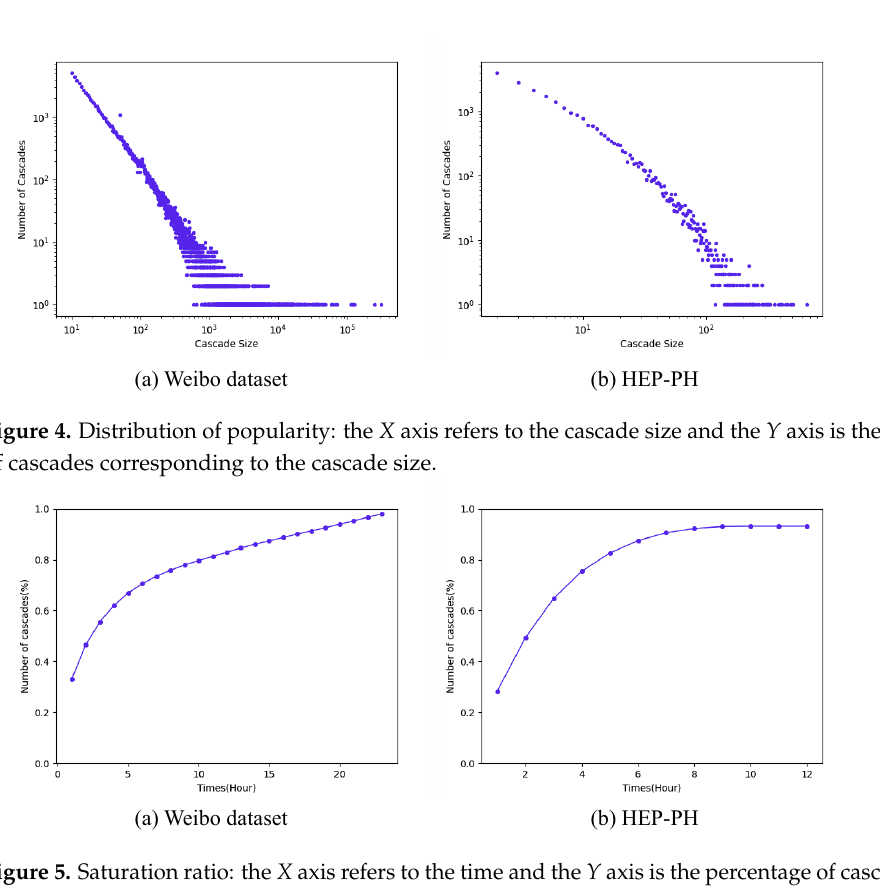
Figure 5. Saturation ratio: the X axis refers to the time and the Y axis is the percentage of cascade size.